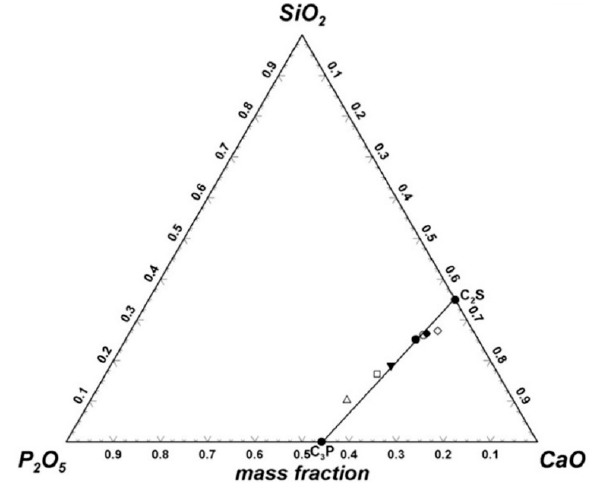
Figure 4. Position of solid solution phase components in different slag samples in the phase diagram of the CaO-SiO 2 -P 2 O 5 ternary system.